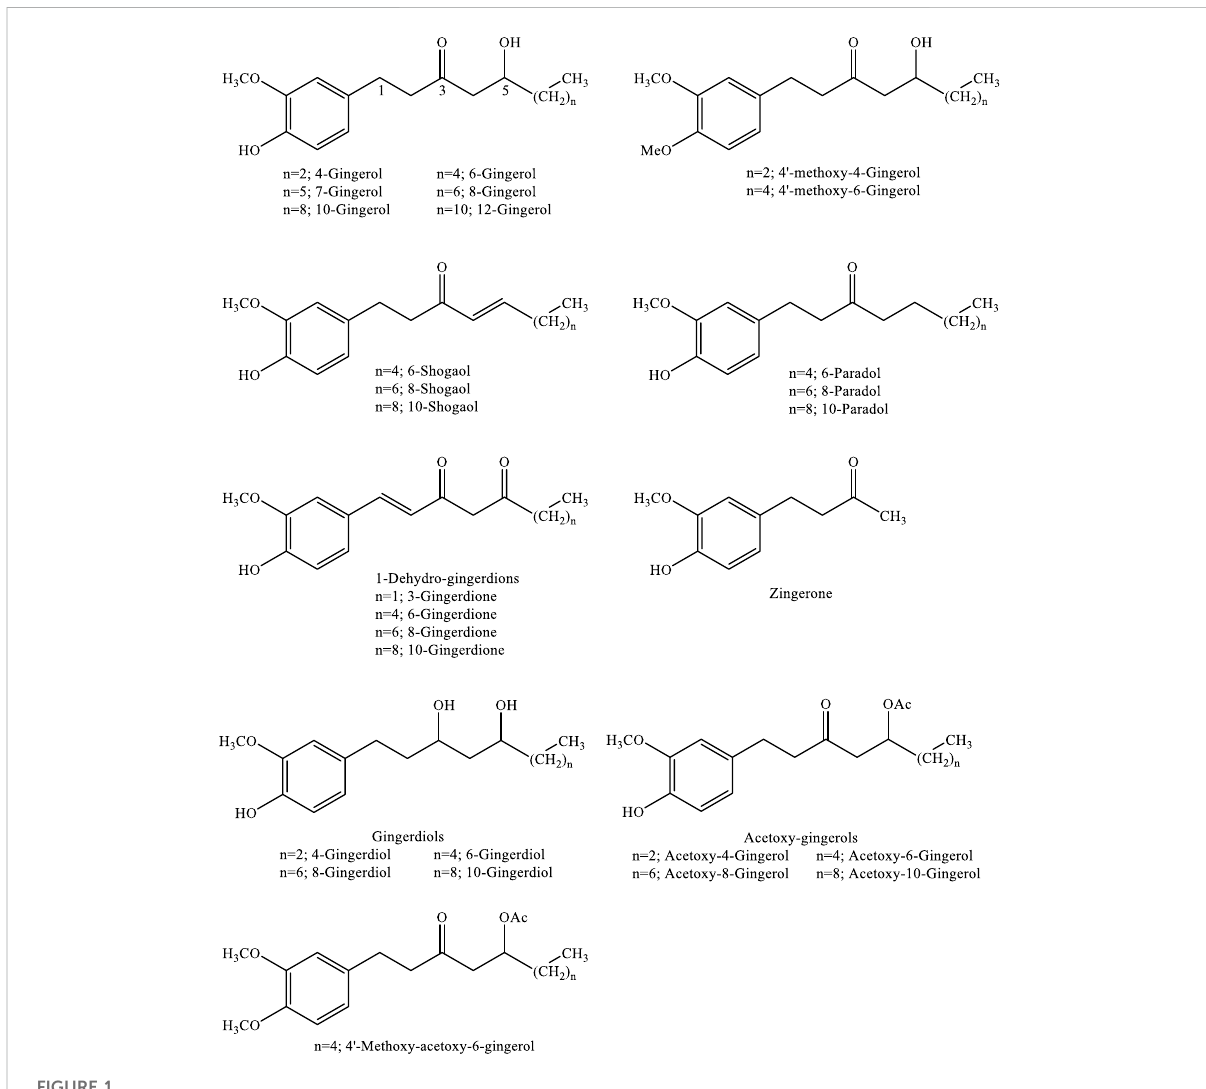
FIGURE 1 Chemical structures of gingerols and gingerol-related